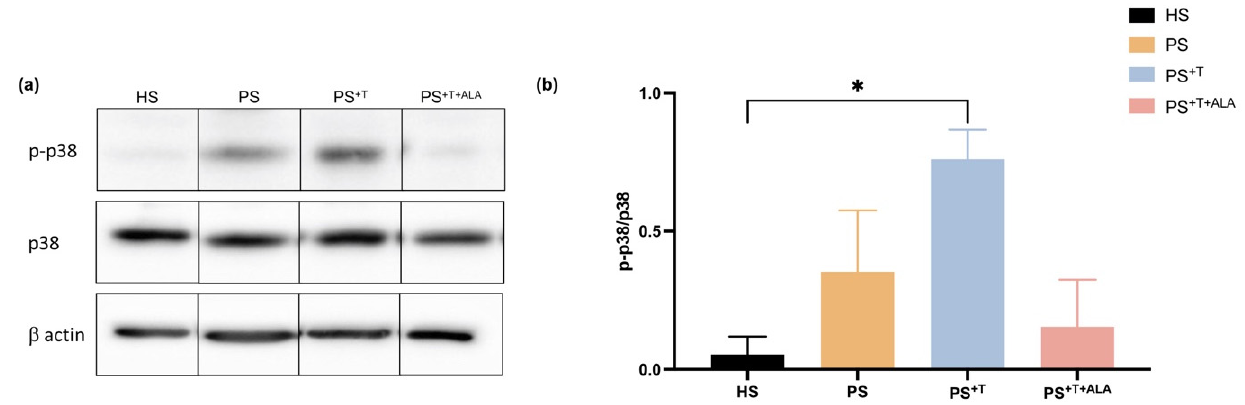
Figure 6. p38 protein expression in HS, PS, PS +T and PS +T+ALA . ( a ) Twenty micrograms of total protein from skin substitutes were analyzed by immunoblot for the presence of p38 and phosphorylated p38 (p-p38). β -actin was used to control equal loading. One representative immunoblot is shown per protein. (N = 3 healthy donors and 3 psoriatic donors per condition; n = 2 skin substitutes per condition); ( b ) Densitometric analyses of the immunoblot from panel ( a ). Statistical significance was determined using one-way ANOVA followed by Tukey’s post hoc test. (* p < 0.05). Abbreviations: ALA: alpha-linolenic acid; HS: healthy substitutes; T: T cells; PS: psoriatic substitutes; PS +T : psoriatic substitutes produced with T cells; PS +T+ALA : psoriatic substitutes produced with T cells and supple-